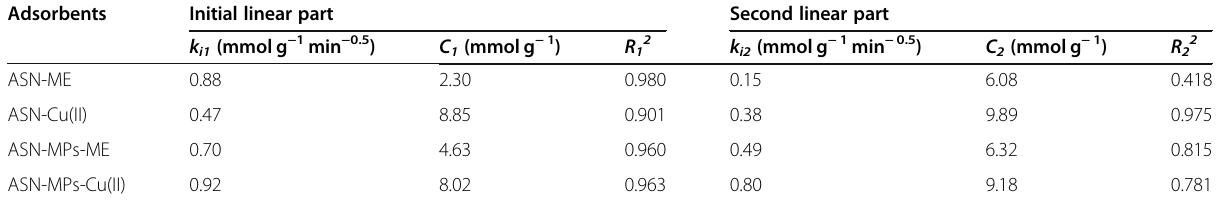
Table 2 Intra particle diffussion model for ME and Cu(II) cations on ASN and ASN-MPs at 27 °C and pH 7 Adsorbents